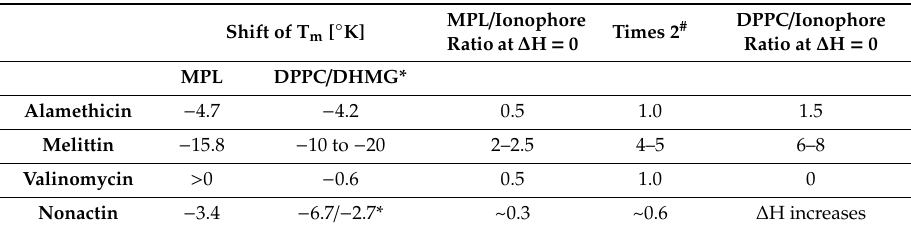
Table 5. Mixture of MPL with